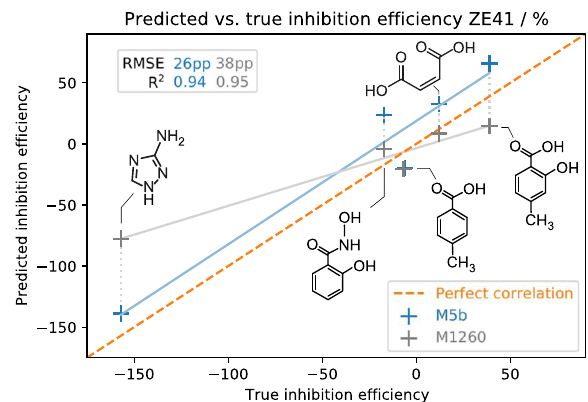
Fig. 3 Model performance. Predicted vs. true target values for the validation sets as obtained by M5b and M1260. Linear regressions are depicted as accordingly colored lines. 3,5-Dinitrobenzoic acid was excluded as it contains features that are outside of the domain of the trained model.